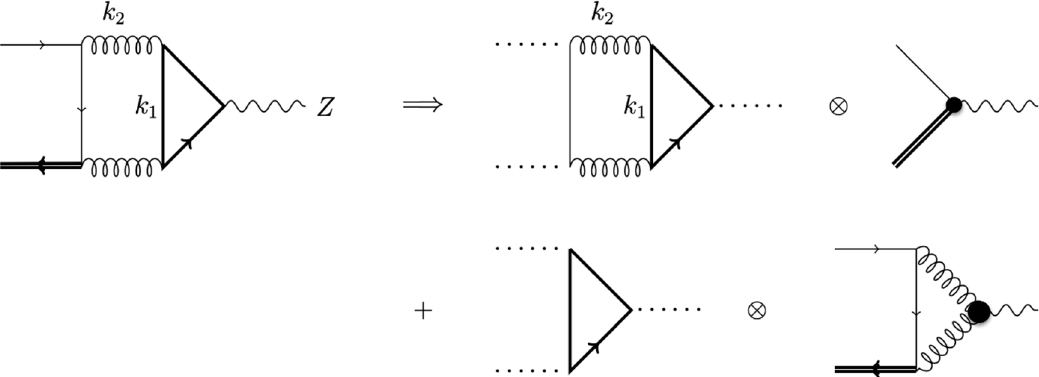
Figure 6 . The heavy-mass expansion of a representative box-triangle diagram with k 1 ; 2 denoting the two loop momenta, drawn in a similar fashion as in (cid:12)gure 5, albeit, with a di(cid:11)erence: the double-thick line represents the amputated b -quark tree propagator, not to be confused with the solid thick triangle representing top quark